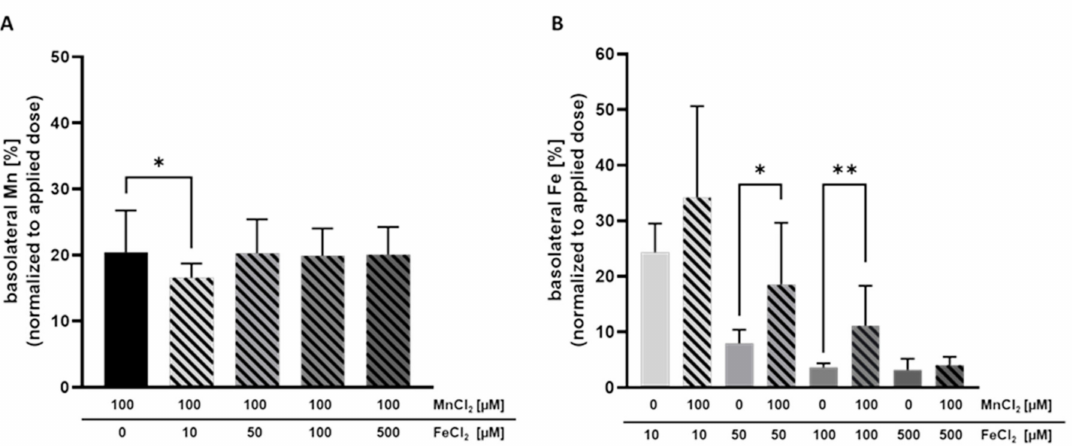
Figure 3. Basolateral Mn and Fe amount after concurrent treatment after 24 h. Shown is the mean + SD of at least three independent experiments with two replicates each. ( A ) Basolateral Mn amount [%] normalized to the applied dose. ( B ) Basolateral Fe amount [%] normalized to the applied dose. Statistical analysis is based on an unpaired t test with Welch’s correction compared to single TE treatment. Statistical analysis is indicated as followed: * p < 0.05, ** p < 0.01 compared to single TE